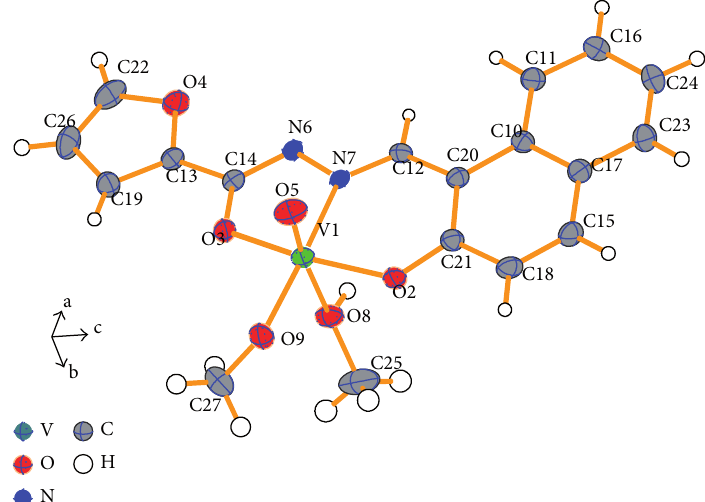
F 1: ermal ellipsoid plot of [VO(L probability level; bond lengths and angles in Table 4.